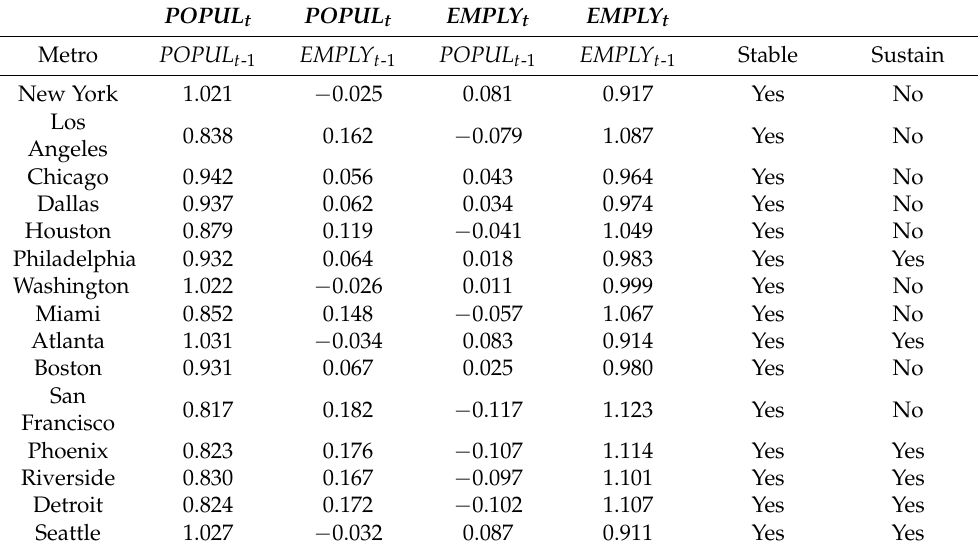
Table 5. Reduced-Form Estimates of Population and Employment: